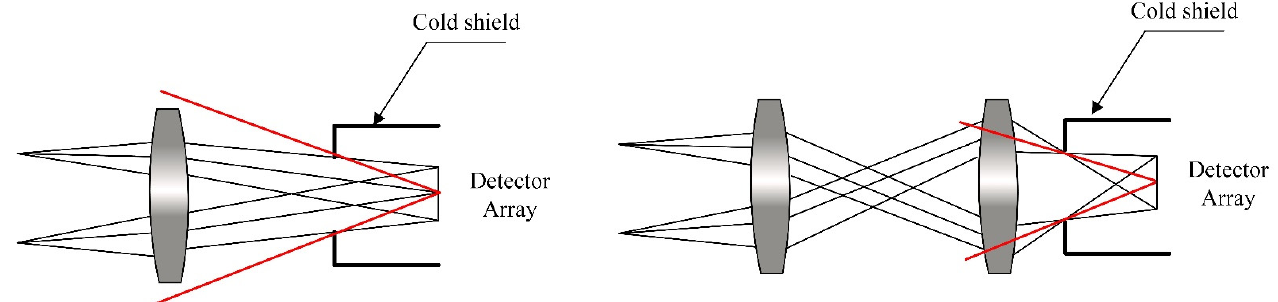
Figure 8. 3D schematic of cross-dispersion structure of echelle spectrometer.